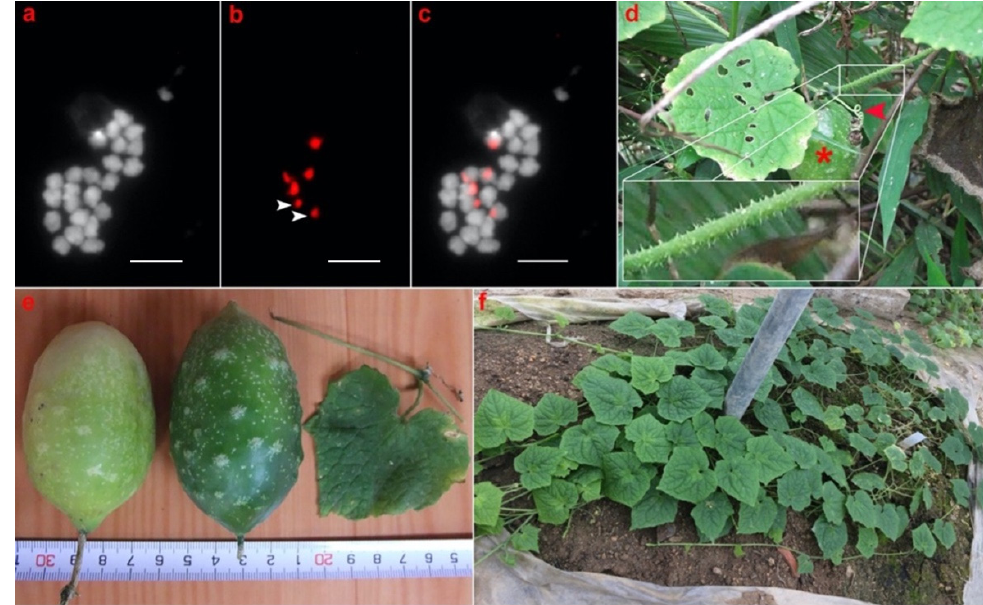
Figure 1. Chromosomal distribution of 45S ribosomal DNA (rDNA) in Cucumis debilis and its mor- phological characters. C. debilis chromosomes stained with 4,6-diamidino-2-phenylindole (DAPI) ( a ); 45S rDNA signals (red) detected with anti-dig rhodamine ( b ); physical mapping of 45S rDNA in C. debilis chromosomes ( c ); C. debilis plant found in Vietnam successfully produced fruits (asterisk) in its habitat ( d ); and had sparsely aculeate tendrils (red arrowhead) for climbing and hairy stem (inset), deeply cordate leaf base, broad triangular leaf lobes with spiny hairs, and acuminate leaf apex, the shape of the fruit is oval with the green-colored immature fruit peel (center) and early mature fruit peel color with a definite break in color from green to slightly yellow (left) and leaf morphology with shallow leaf lobe ( e ); C. debilis plant grown and maintained in Okayama Univer- sity greenhouse and failed to develop flowers and fruits ( f ). Arrow heads depict the minor signals of 45S rDNA. Scale bar in ( c ) = 10 μ m.